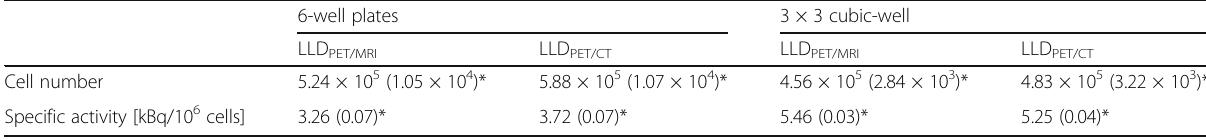
Table 1 Theoretical lower limit of detection (LLD) for PET/CT and PET/MRI with respect to cell number and specific